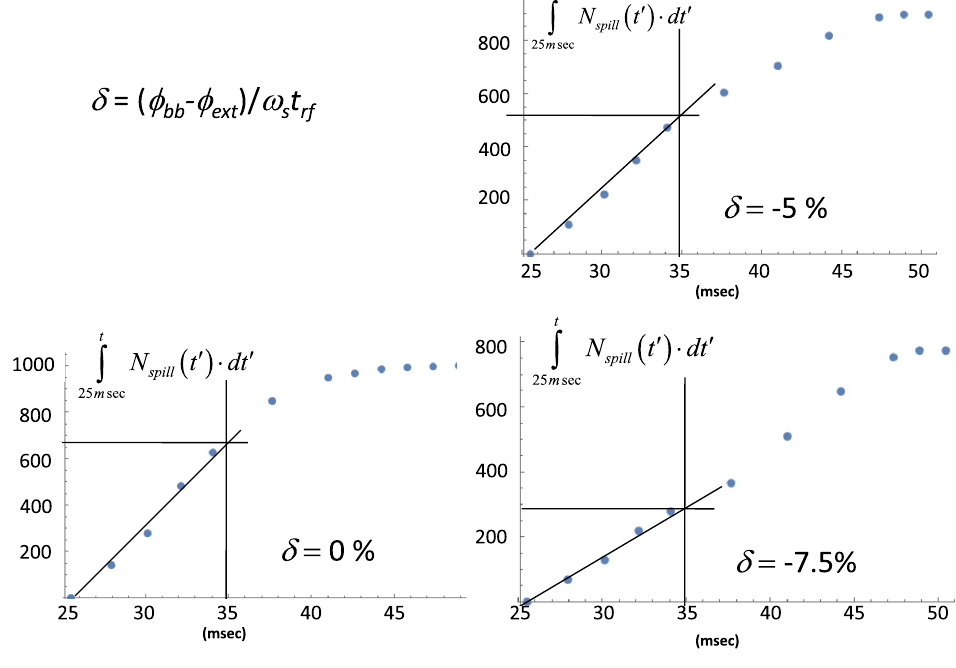
FIG. 14. Integrated spill for different values of δ .